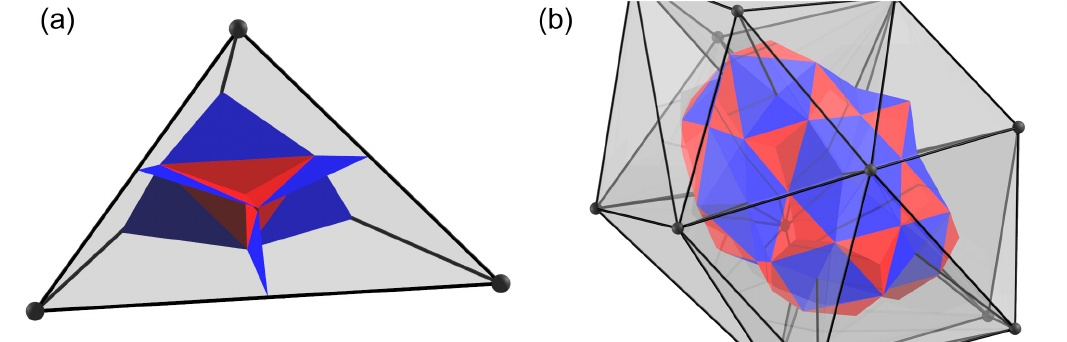
Figure 1. ( a ) Triangular surfaces subdividing the tetrahedron into four subdomains with equal volumes by using the tetrahedron centroids. The blue region consists of two centroids of the surface and one centroid of the edge, and the red region consists of two centroids of the surface and one centroid of the volume. ( b ) One volume element enclosed by the subdivided triangular